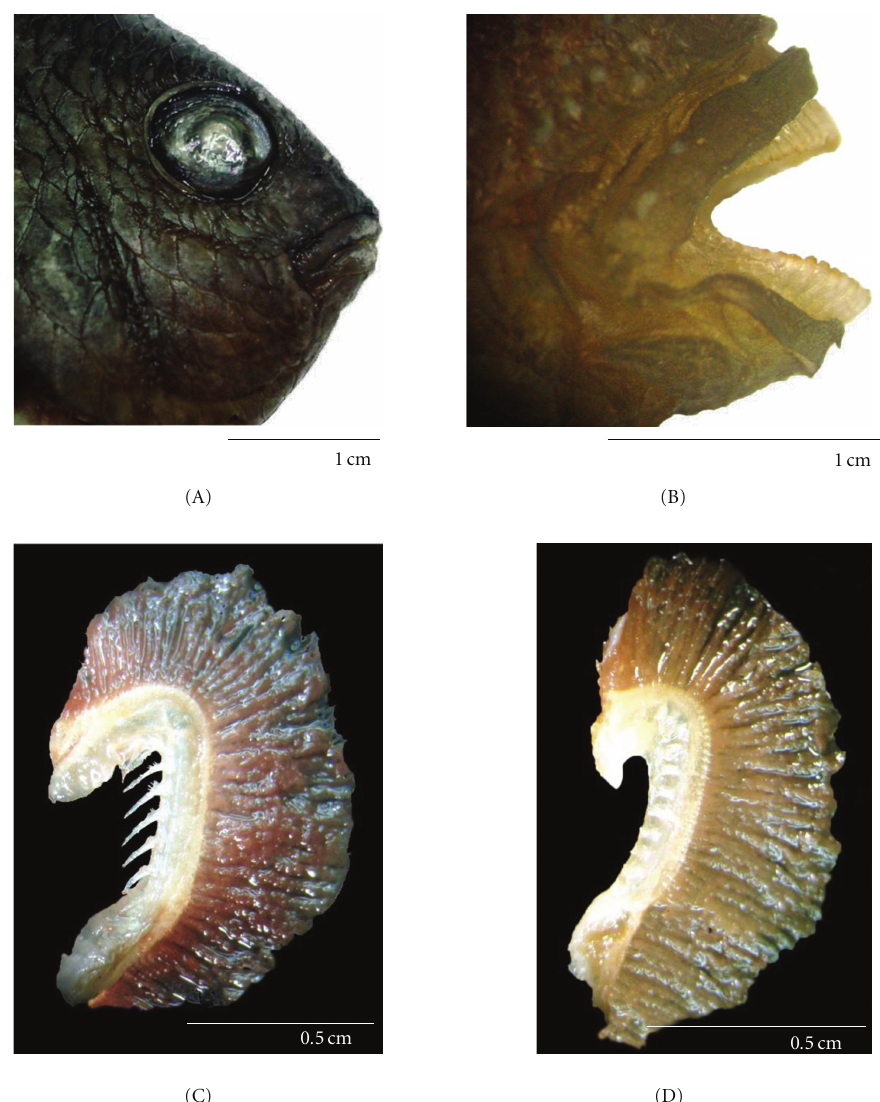
Figure 1: Lateral view of the head of S. fuscus: (A) mouth closed; (B) mouth open showing the teeth; (C) the first branchial arch showing the gill rakers; (D) the second branchial arch.